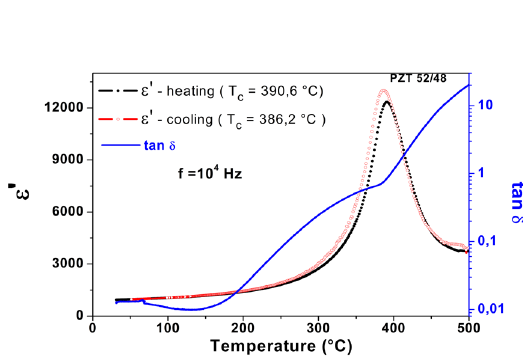
Figure 11. Dependence with temperature of the real part of the permittivity and tanδ (f = 10 4 Hz). A small thermal hysteresis is observed in the heating and cooling curves for undoped PZT 52/48 sample.